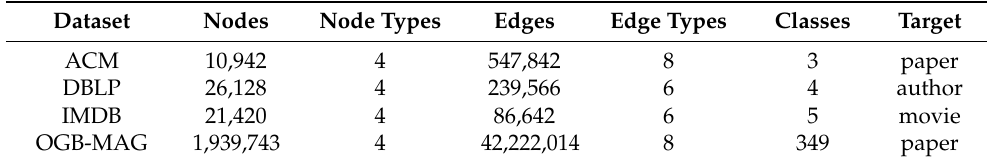
Table 1. Statistics of datasets used in this